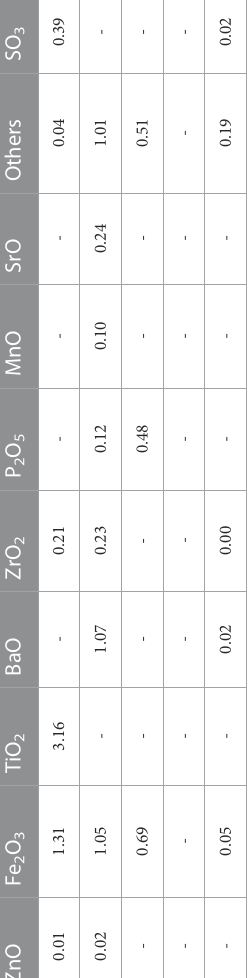
Figure 2 show the digital photographs of sintered samples. Figures 2A – D represent the sintered samples (labled GFA1-GFA4) with QS content of 20wt%, 15wt%, 10wt% and 5wt% in the glaze paste formula, respectively. Figure 2E represents the sintered body. Clearly, the glaze layers are perfectly fi tting on the green bodies, and all samples show good opalescence and strong covering ability. However, the opalescence effect of samples fi rst increased and then decreased with the increase of quartz sand content, which is because the quartz sand content affects the high temperature viscosity and sintering temperature of the glaze layer. Under the condition of a certain temperature, the higher the content of quartz sand is, the higher the viscosity of the glaze layer is, and the worse the melting property is. Obviously, GFA1 has a thick glaze layer due to poor melting. And, the surface presents obvious stress cracks, which is due to the high content of quartz sand, resulting in high Si/O radio in the glaze, so that the silicon-oxygen tetrahedral network connection in the glaze layer is strong, which improves the elastic modulus of the glaze layer, and then B reduces the elasticity of the glaze layer, so it is easy to appear stress- T A